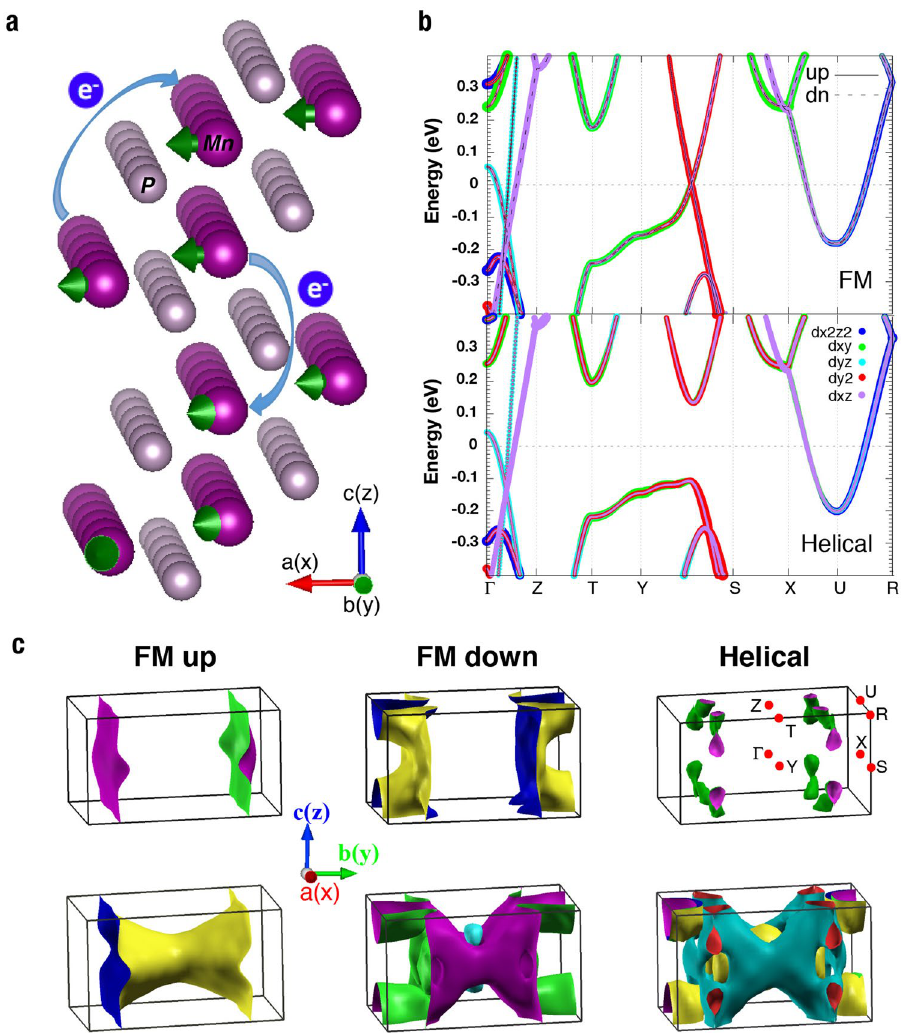
Figure 7. Band structures and Fermi surface topology of MnP. ( a ) Illustration of the crystal structure and the helimagnetic order. The green arrows point to the directions of the ordered moments; the light blue arrows with the symbol “e − ” denote the electron hopping between Mn-ions, implying the itinerant character of the Mn d - electrons. ( b ) Comparison of the band structures in the ferromagnetic and helimagnetic states. ( c ) Comparison of the Fermi surfaces for the ferromagnetic and helimagnetic states. The top panels show the quasi-1D Fermi sheets (mainly of d -character) in the ferromagnetic state and their suppression in the helimagnetic state. The y 2 bottom panels show the rest parts of the Fermi surfaces from other